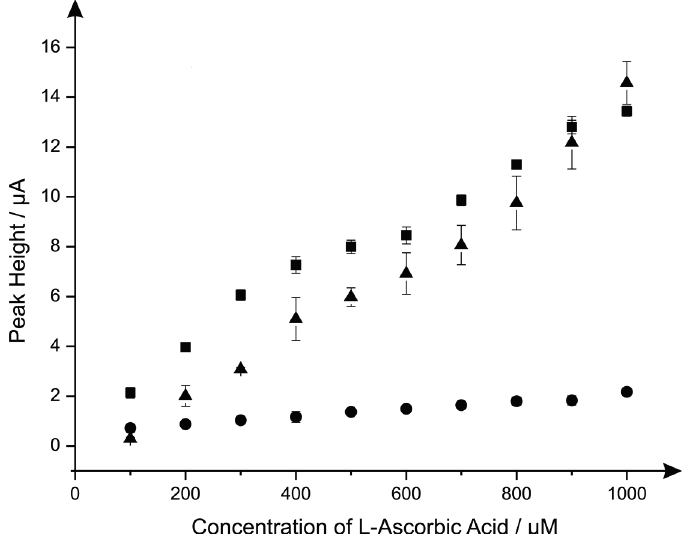
Figure 4. Calibration plots with error bars ( N = 3) arising from the electroanalytical detection L -ascorbic acid over the concentration range 100 to 1000 µM within a pH 7.4 PBS using 20 µg nano-CoTAPC SPEs (circles), CoPC-SPEs (squares) and a standard-SPE (triangles). The voltammetric peak observed at ~ +0.30 V ( vs. SCE) was utilised to construct the calibration plot, with a new electrode used at each concentration. Scan rate: 100 mV s − 1 using cyclic